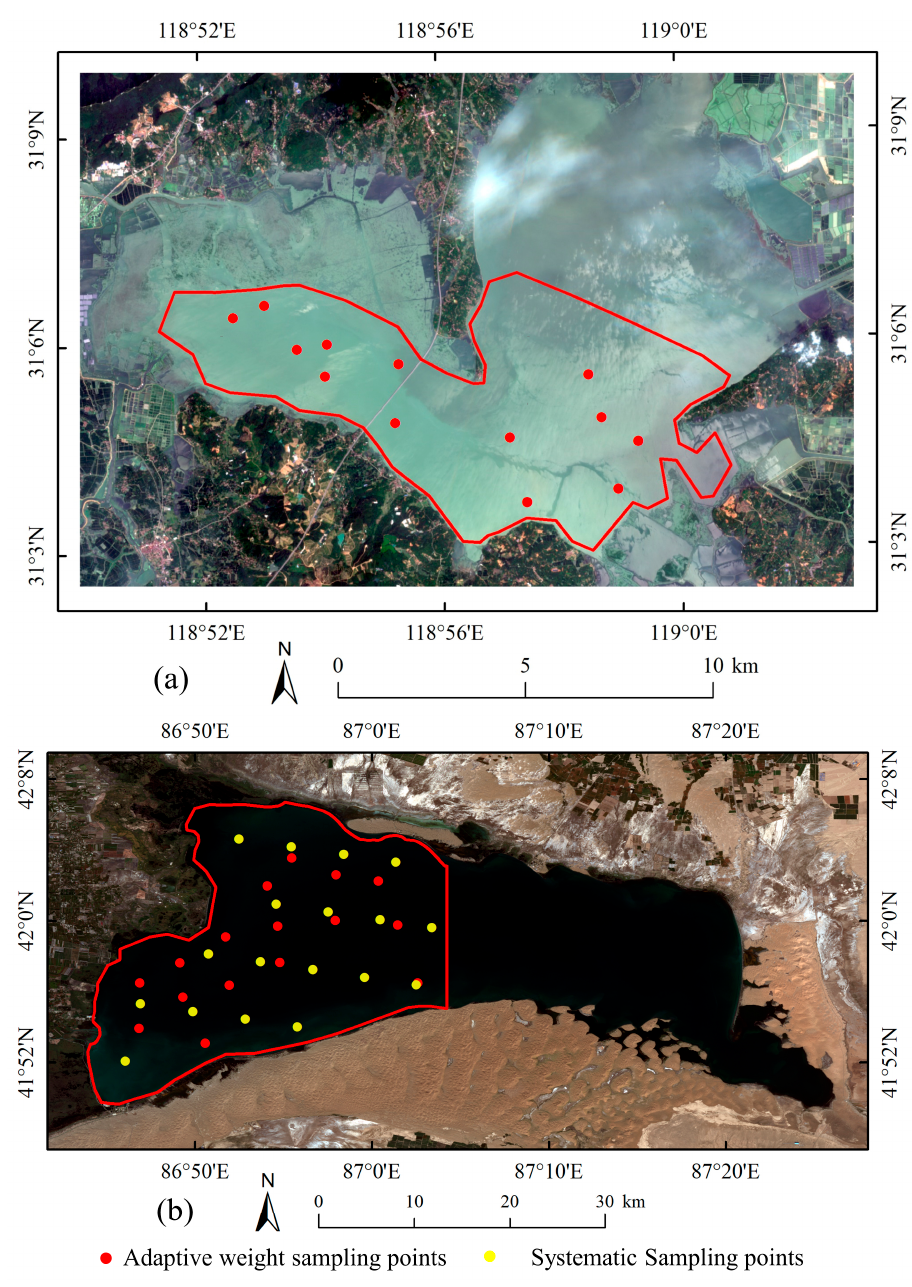
Figure 1. The geographical location of the two experimental areas in this study, the sampling area, is in the red box: Nanyi Lake ( a ) and Boston Lake ( b